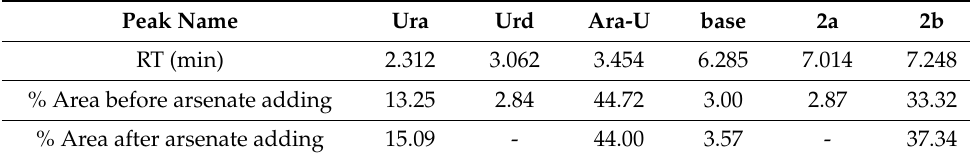
Table 2. Retention time (RT) and peak area of